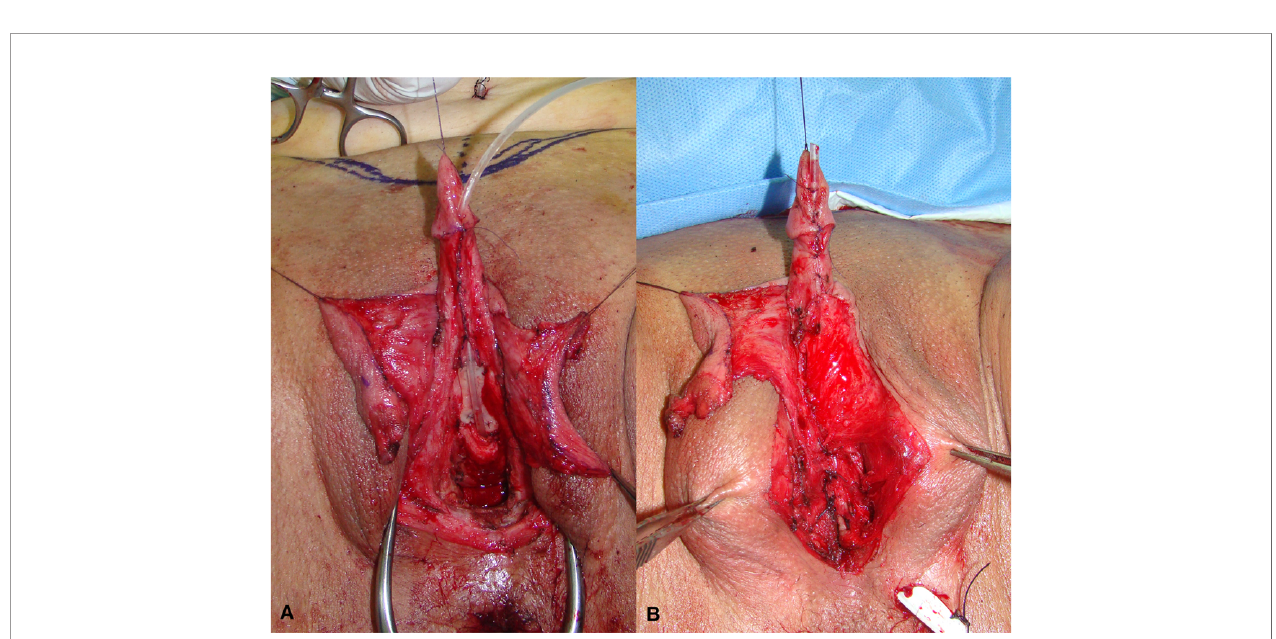
FIGURE 6 | Labia skin graft is fi xed in the gap between divided urethral plate (A) ; left labial skin fl ap is used for urethral tubularization, while fl ap pedicle is used for covering of the suture lines; distal urethra is created by simple urethral plate tubularization and glans closure (B)